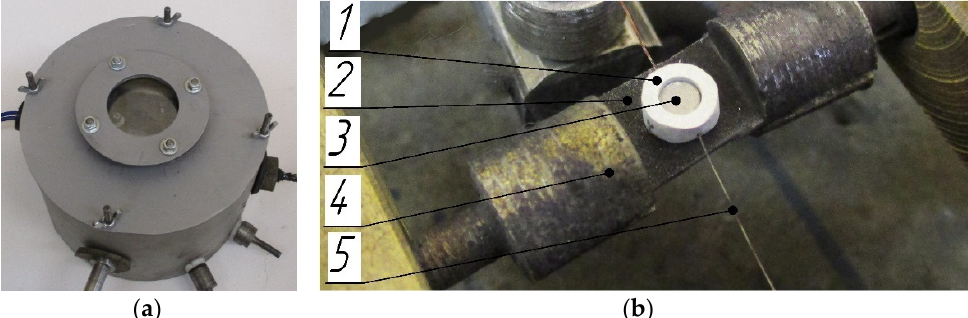
Figure 2. Schematic of the combustion rate measurement: ( a ) specimen; ( b ) rate measurement: (1) current conductor, (2) flat graphite heater, (3) specimen, (4) refractory substrate, (5) WR5/20 ther- mocouples.